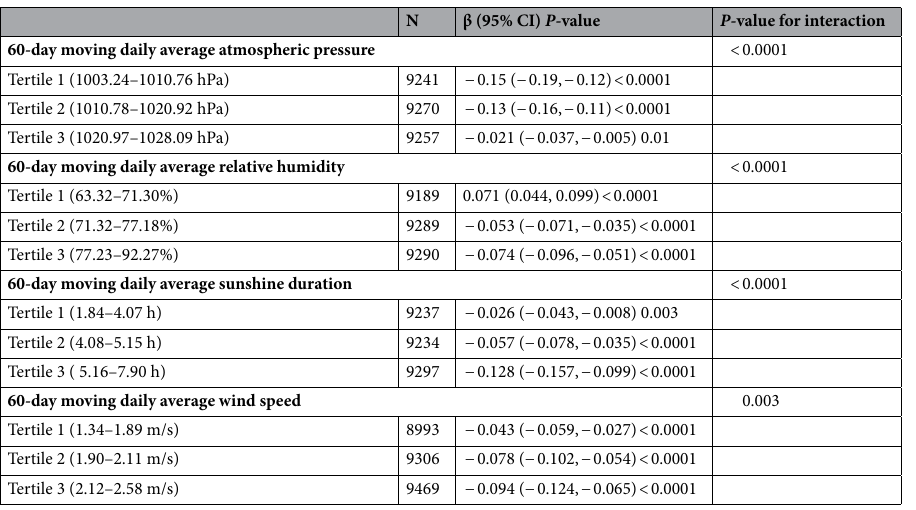
Table 6. Associations between 60-day moving daily average PM 10 levels and maternal serum 25OHD levels during second trimester of pregnancy in subgroups stratified by meteorological factors. Adjusted for year, season, 60-day moving daily average atmospheric pressure, sunshine duration, relative humidity and wind speed except the subgroup variable. PM 10 particulate matter with an aerodynamic diameter of ≤ 10 μm, 25OHD 25-hydroxy vitamin D, CI confidence